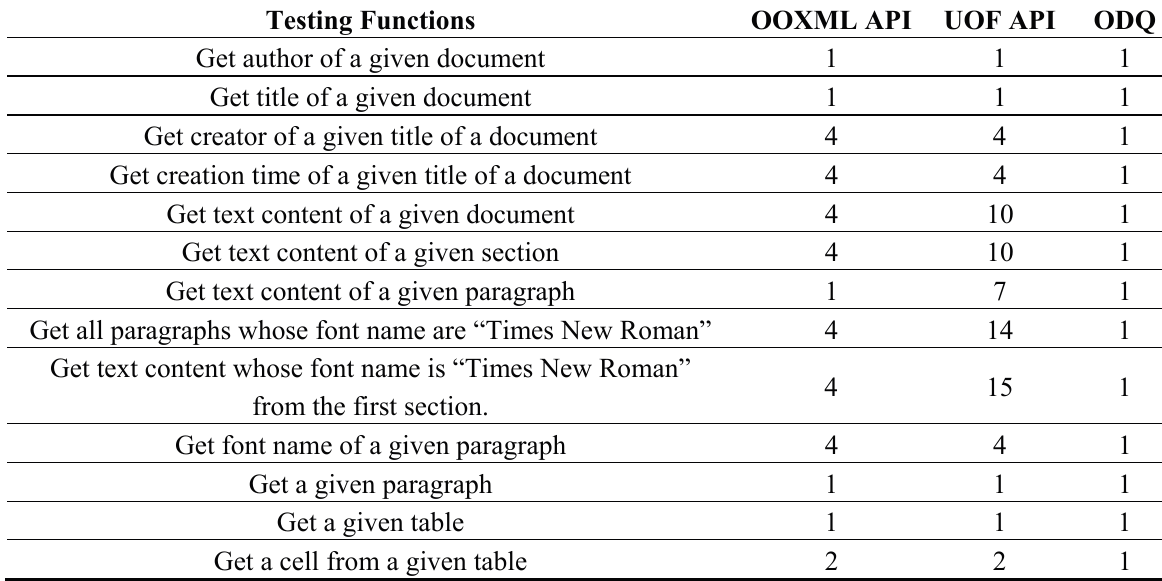
Table 3. Amounts of code of three methods.